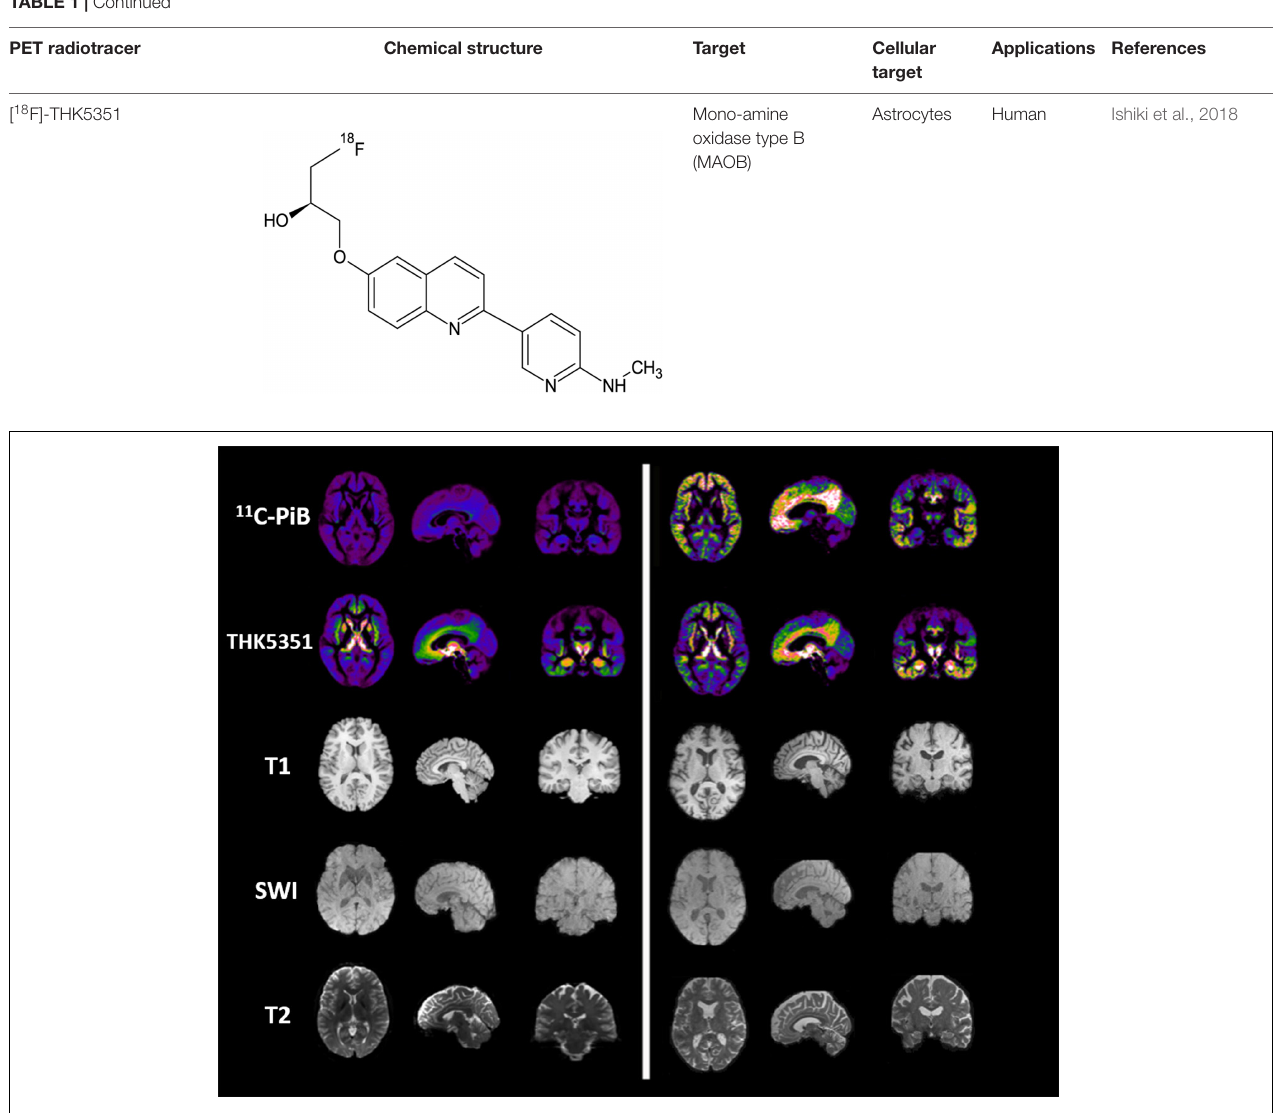
FIGURE 2 | Imaging examples in PET and MR imaging. The figure depicts, from left to right, axial, sagittal and coronal projections of healthy (Left) and AD spectrum (Right) brain for different PET (Shigemoto et al., 2018) and MR contrasts. From top to bottom row: microglial uptake as revealed by 11C-PiB PET tracer; astrocytic uptake as revealed by 18F-THK5351 PET tracer; structural 3D T1-weighted MR used as anatomical reference for PET and to highlight cortical atrophy and ventricular enlargement; 3D Susceptibility-weighted imaging MR linked to iron deposition and microgliosis; T2-weighted MR scan used for T2 mapping and